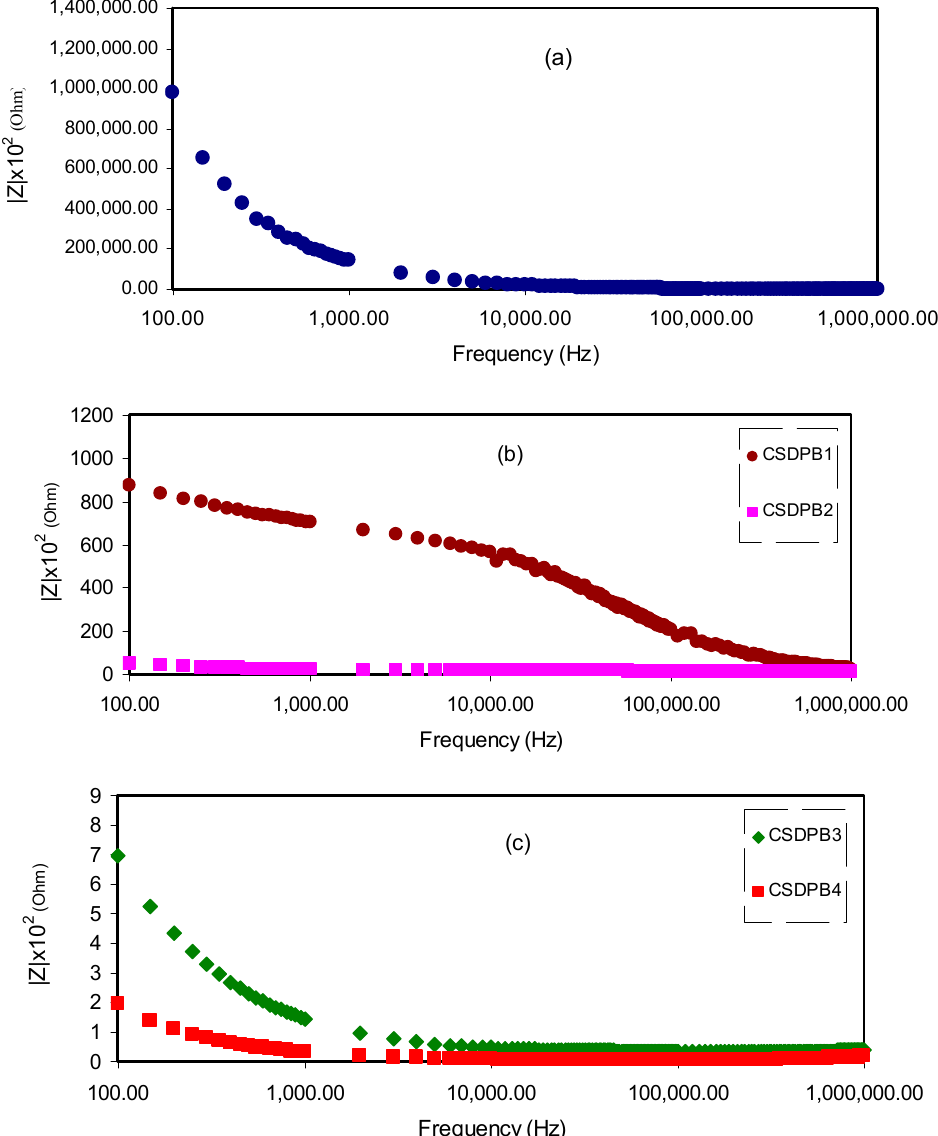
Figure 6. Bode plots for ( a ) pure CS:Dextran film ( b ) CSDPB1 and CSDPB2, and ( c ) CSDPB3, and CSDPB4 blend electrolyte films. Table 1. DC conductivity for pure CS:Dex and blend electrolyte films at room temperature.